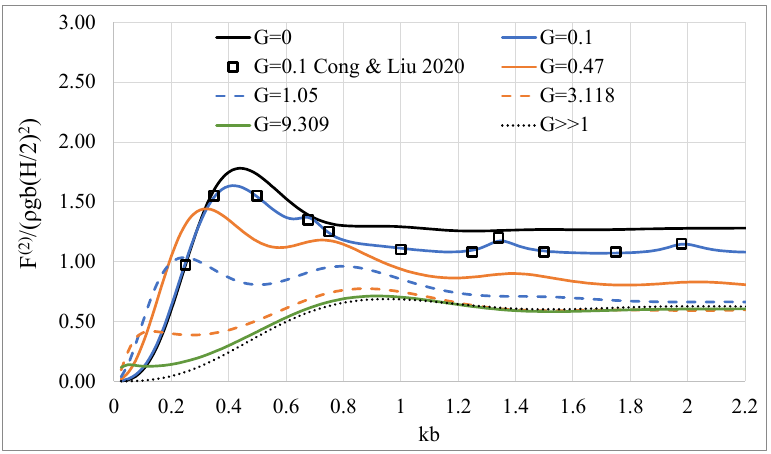
Figure 6. Effect of the porous coefficient 𝐺 on the mean drift forces on a porous bottom-mounted